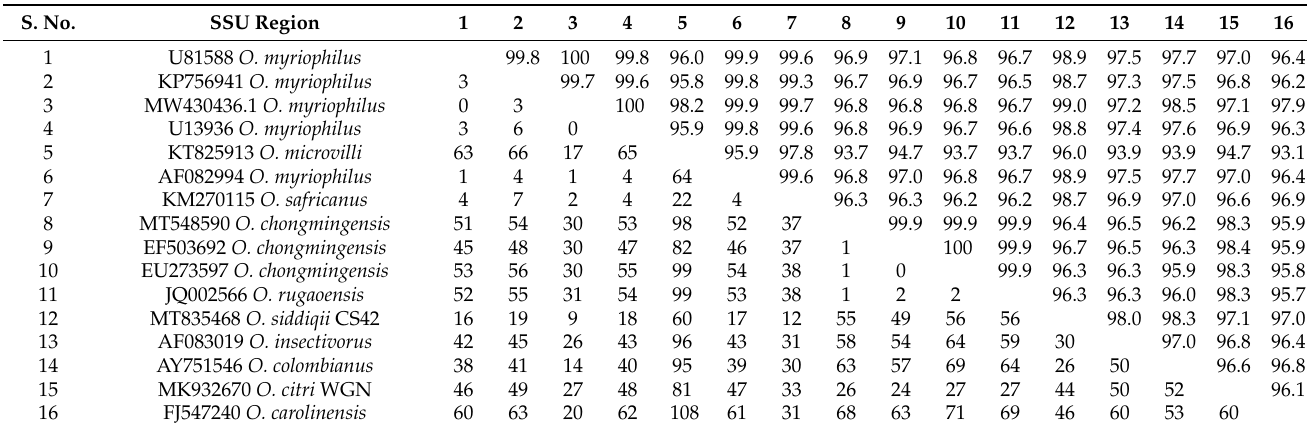
Table 4. Pairwise distances of the SSU region of the rDNA among species of the “ insectivorus ” group of the genus Oscheius . The values above the diagonal represent percent similarities, and values below the diagonal represent numbers of character differences.